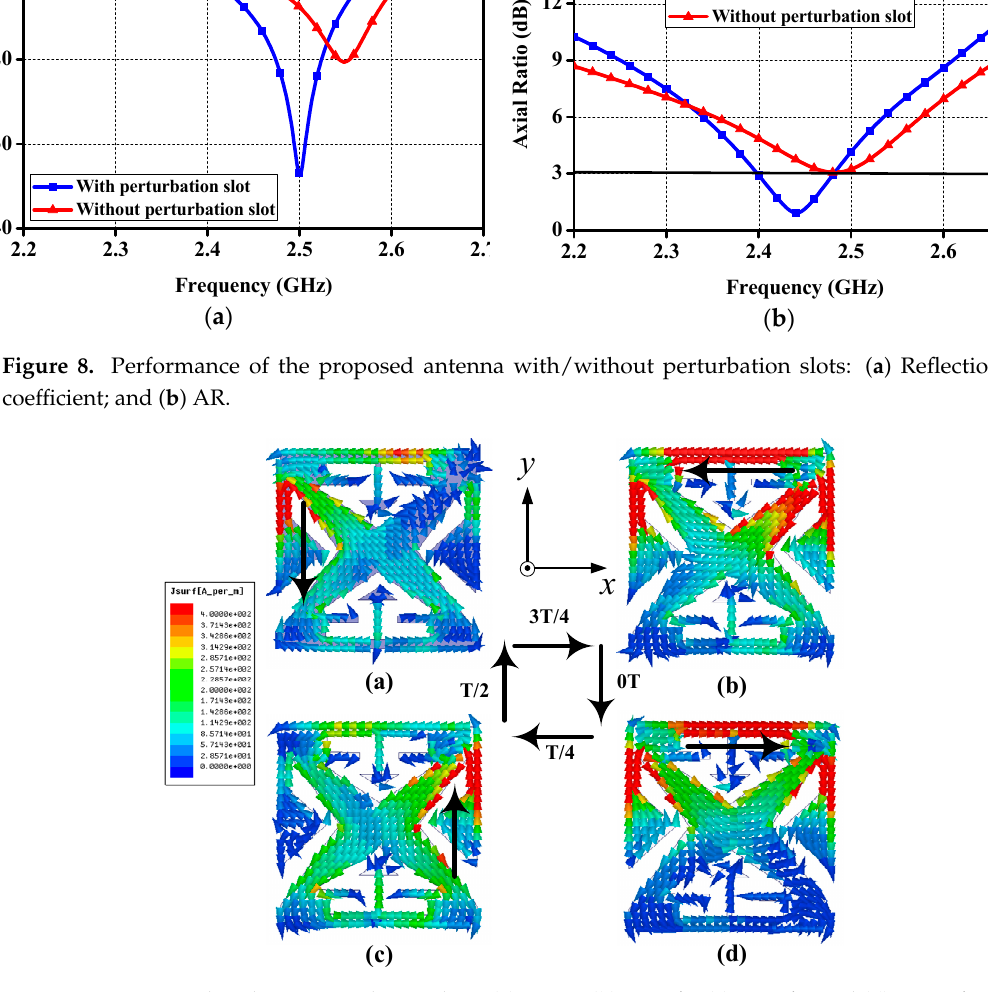
Figure 9. Current distributions on the patch at: ( a ) t = 0T; ( b ) t = T/4; ( c ) t = T/2; and ( d ) t = 3T/4.